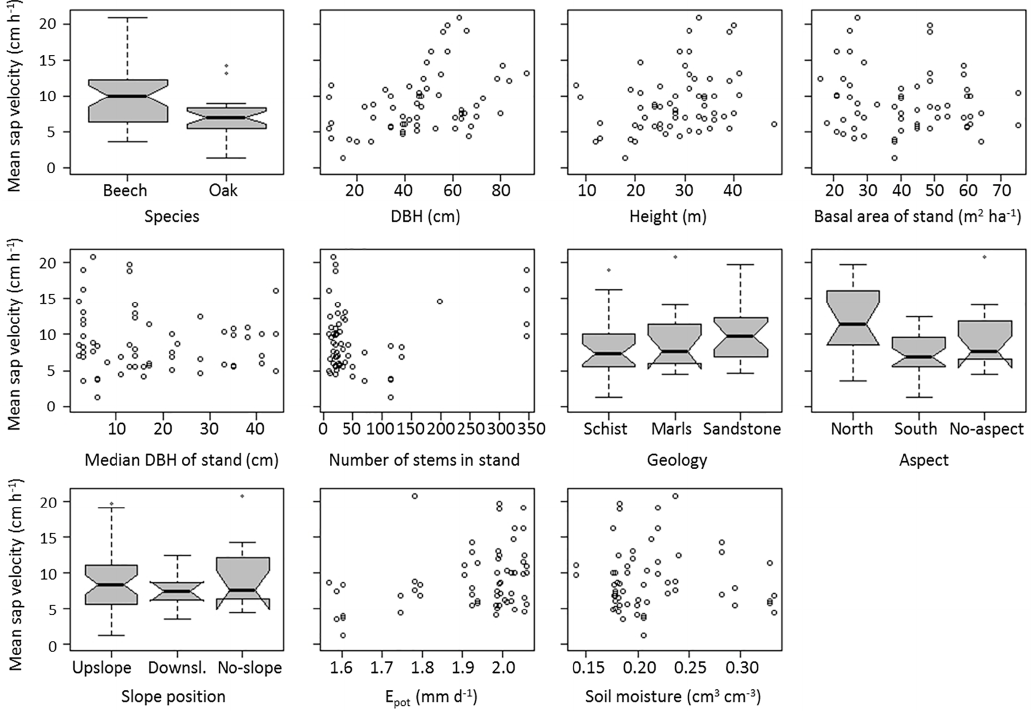
Figure 4. Univariate influence of each predictor on sap velocity means for each tree over the entire study period. Box plot parameters are as follows: the horizontal line within the box visualises the median, boxes comprise data between the 1st and 3rd quartile of the data, whiskers reach to 1.5 × the interquartile range outside the box (or to the maximum/minimum value if smaller/larger), circles stand for outliers or data points outside the whiskers, notches show approximately 95% confidence intervals around the medians.